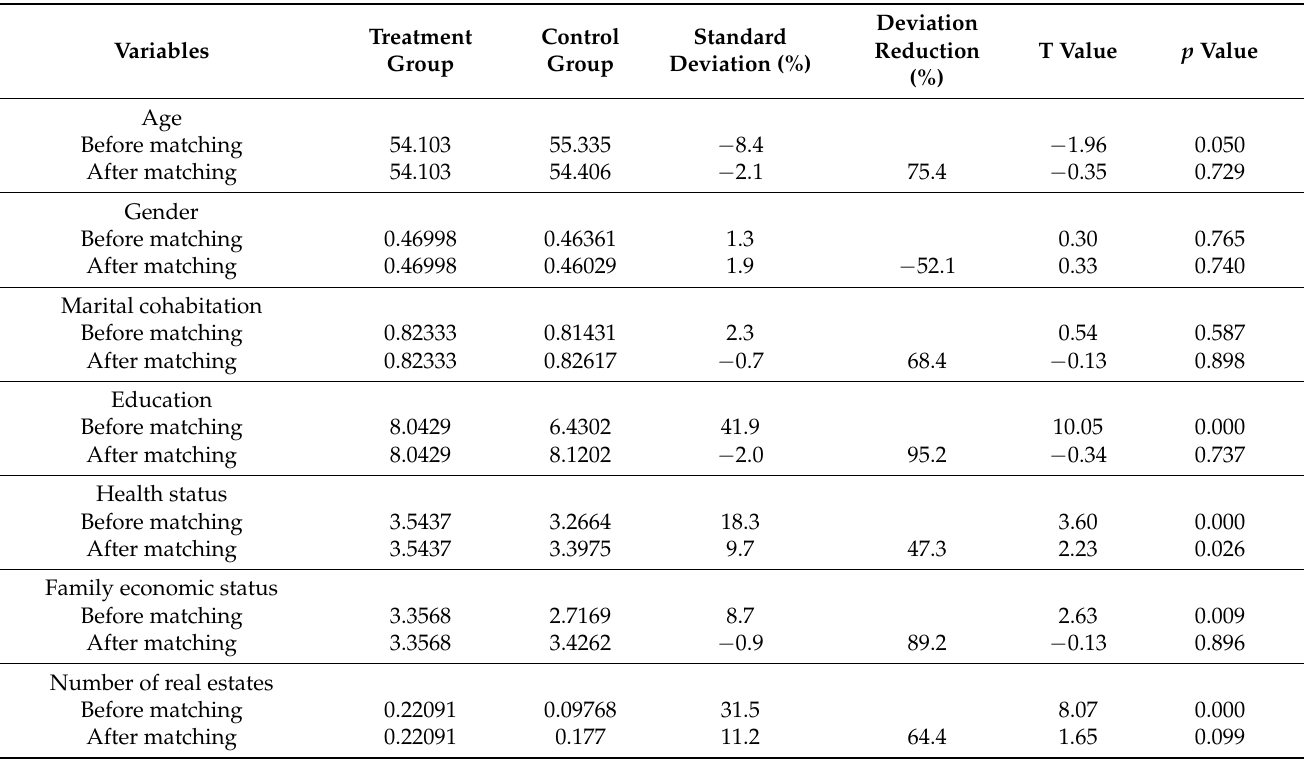
Table 4. Sample balance